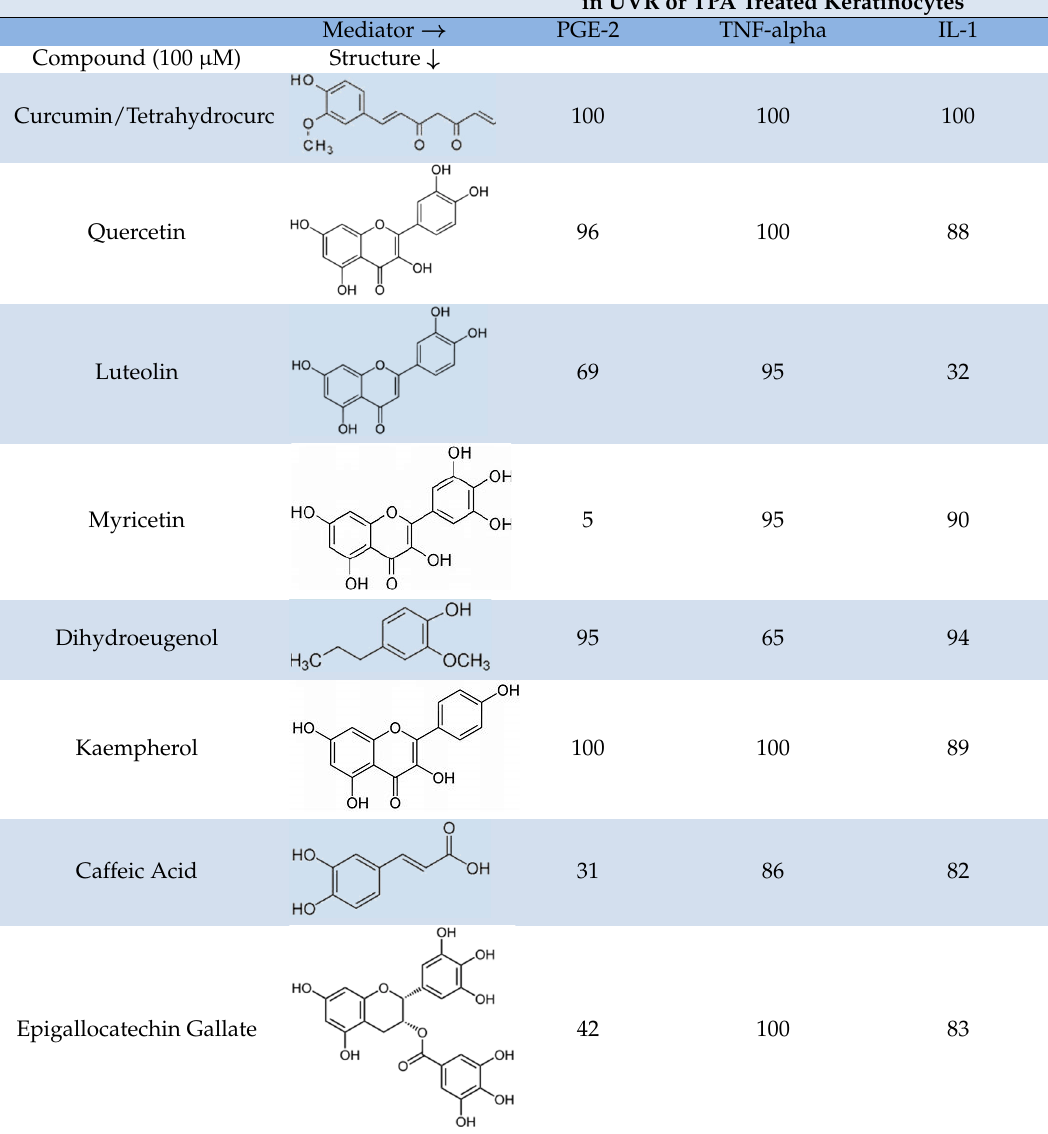
Table 2. Anti-inflammatory effects of natural phenolic compounds. Human keratinocyte cells were seeded into 12 well culture dishes and allowed to attach overnight. For irradiation experiments cultures irradiated with 50 mJ of UVB radiation, and fresh medium added that contained either the compound under investigation (100 µM) or the solvent for the compound used as vehicle control. After 24 h, medium was removed and assayed by commercial ELISA assay kits for either PGE-2, TNF-alpha, or IL-1. For experiments with TPA cells were treated with TPA (phorbol 12-myristate 13-acetate,20 ng/mL), or 0.2% DMSO as a control After 24 h medium was removed and assayed by ELISA for PGE-2, TNF-alpha or IL-1.